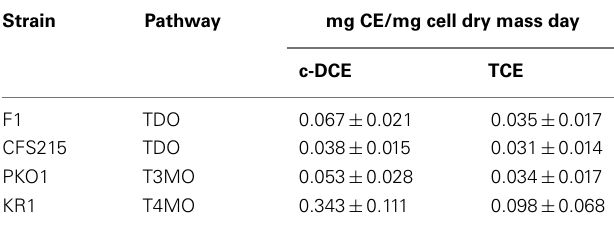
Table 1 | Degradation rates over the first 12h ± 1 SD for cis -1,2-dichloroethene (c-DCE) and trichloroethene (TCE) by four bacterial strains: Pseudomonas putida F1, P. fluorescens CFS215,